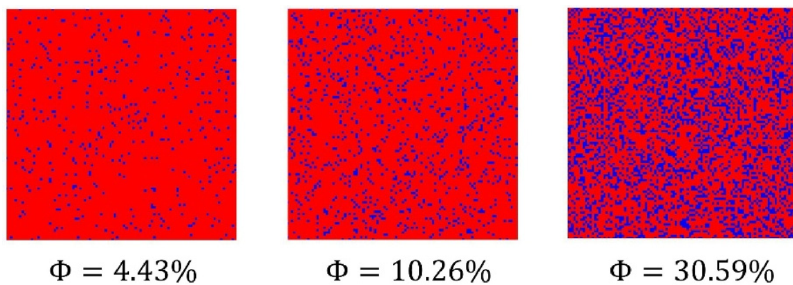
Figure 3. Random distribution void defects with different volume fractions.